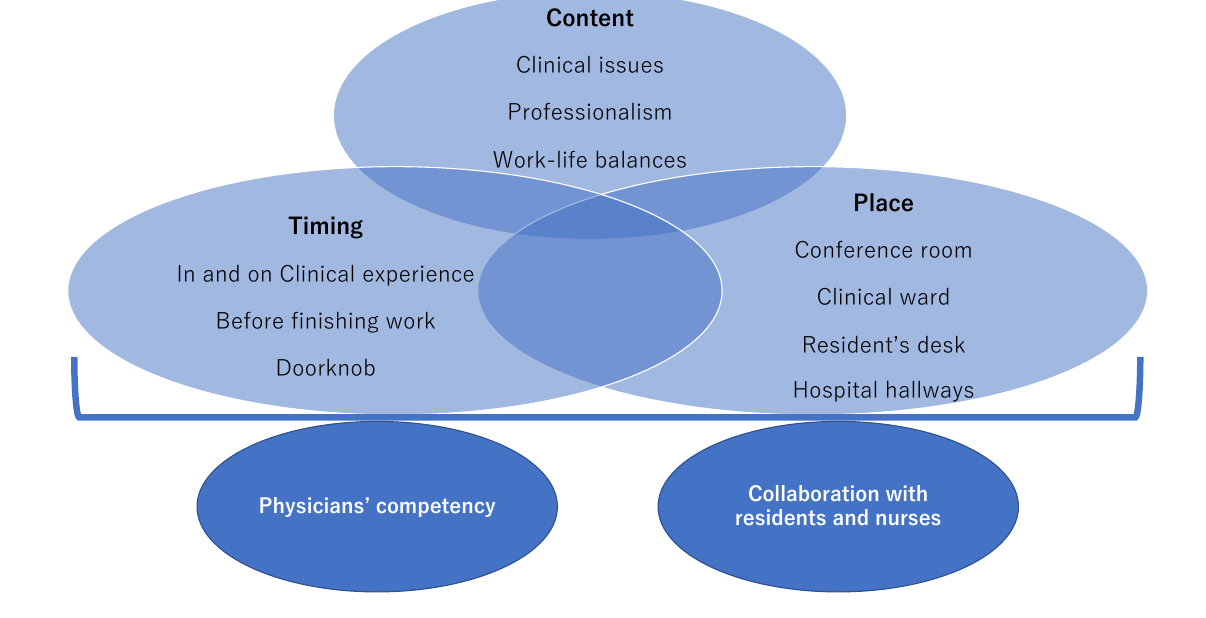
Figure 2. The framework of reflection in rural family medicine